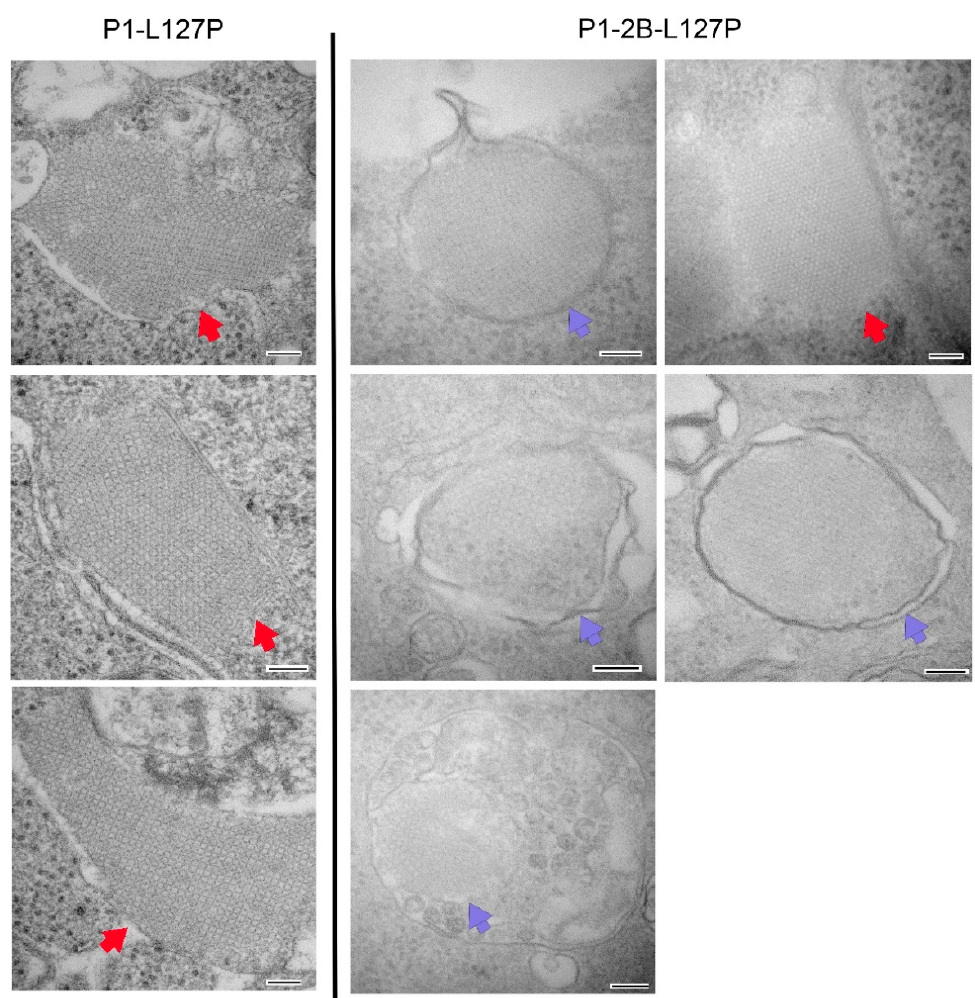
Figure 4. TEM images of VLP arrays within HEK293-T cells transfected with plasmids P1-L127P or P1-2B-L127P. In cells transfected with P1-2B-L127P, multiple arrays were found encapsulated by membrane vesicles. Scale bar represents 100 nm. Red arrows point to VLP arrays not definitively encapsulated by membrane structures while blue arrows point to VLP arrays observed encapsulated by membranes.